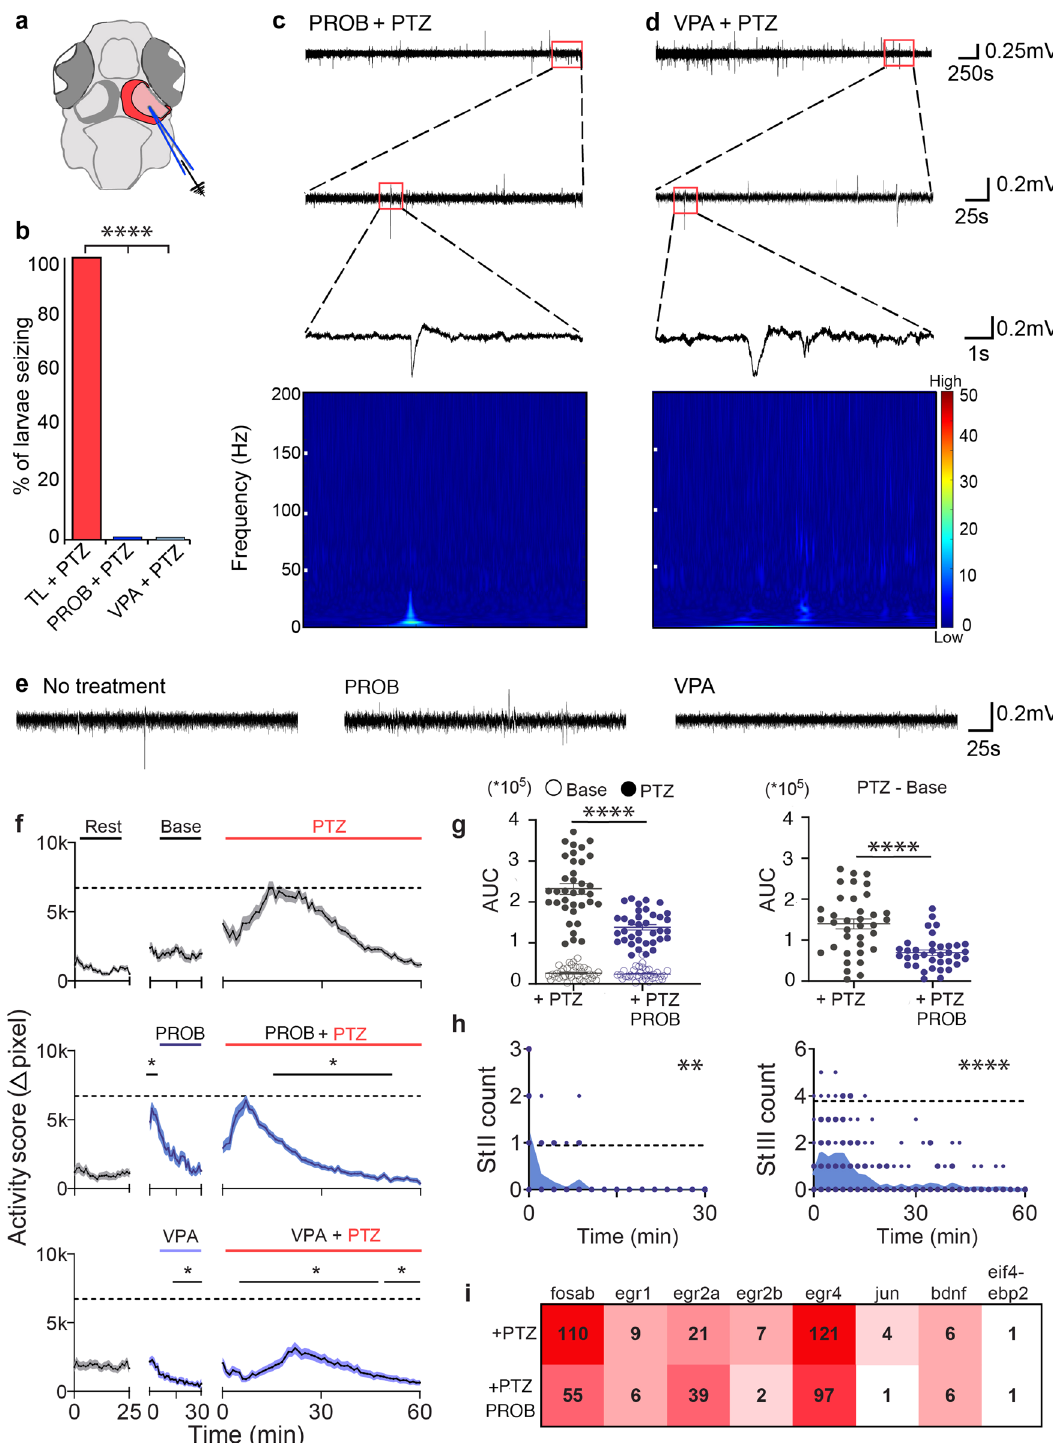
ADP/ATP antiporters ( slc25a4 ), or transport across the inner membrane of mitochondria ( slc25a40 ), was reduced. Although the exact function of the upregulated slc3a2b in the zebra fi sh is unknown, in humans, heterodimers of SLC3A2 with the large neutral amino acid transporter (LAT1) function as sodium- independent, high-af fi nity transporters that mediate uptake of large neutral amino acids such as phenylalanine, tyrosine, L- DOPA, leucine, histidine, methionine, and tryptophan. Although the analysis presented only a snapshot of relevant